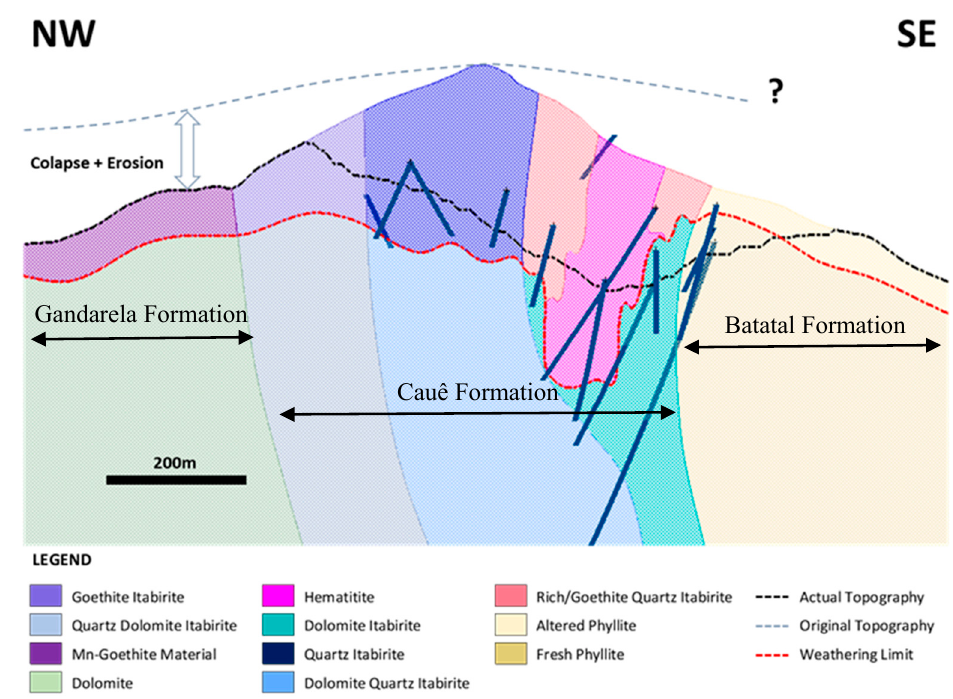
Figure 18. Vertical Section of an Iron Deposit of VALE.